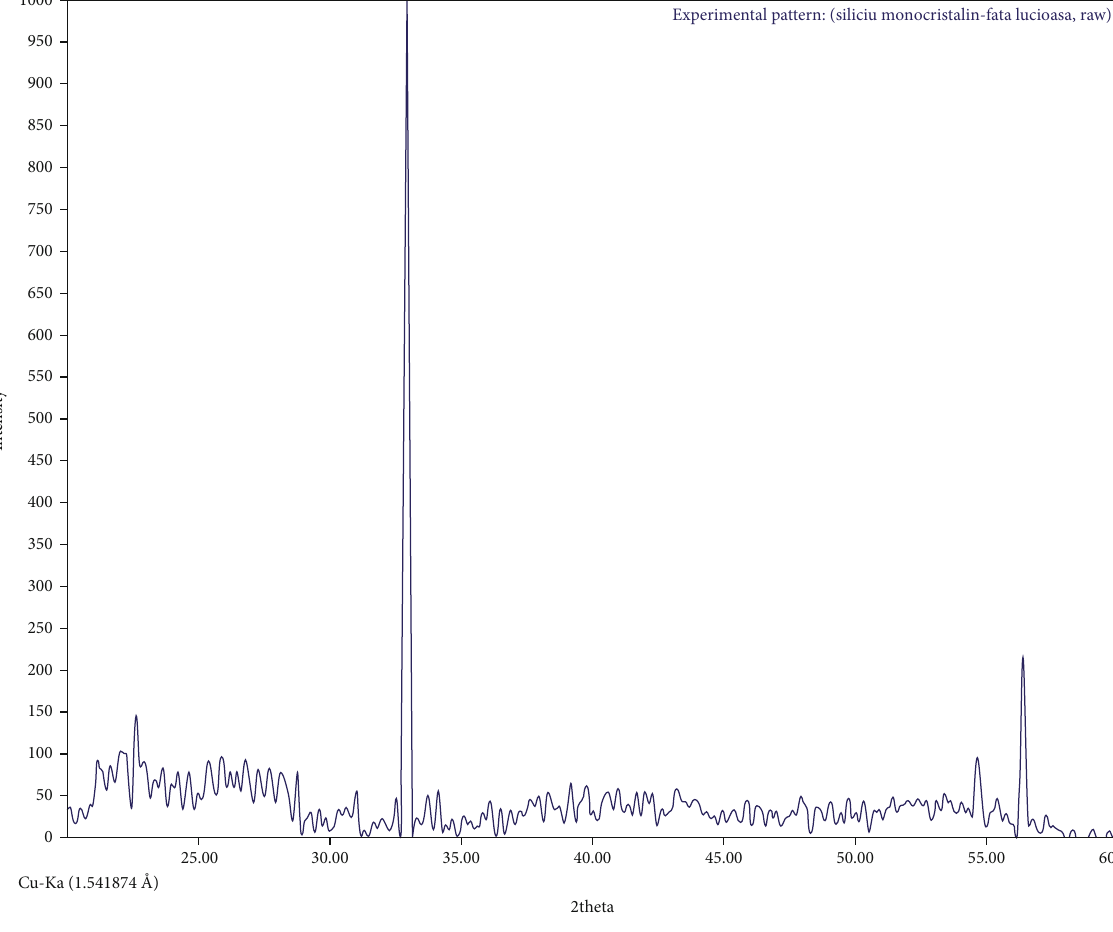
Figure 5: Di ff ractometry spectrum realised using X-ray on smooth-faced of monocrystalline silicon solar cell.